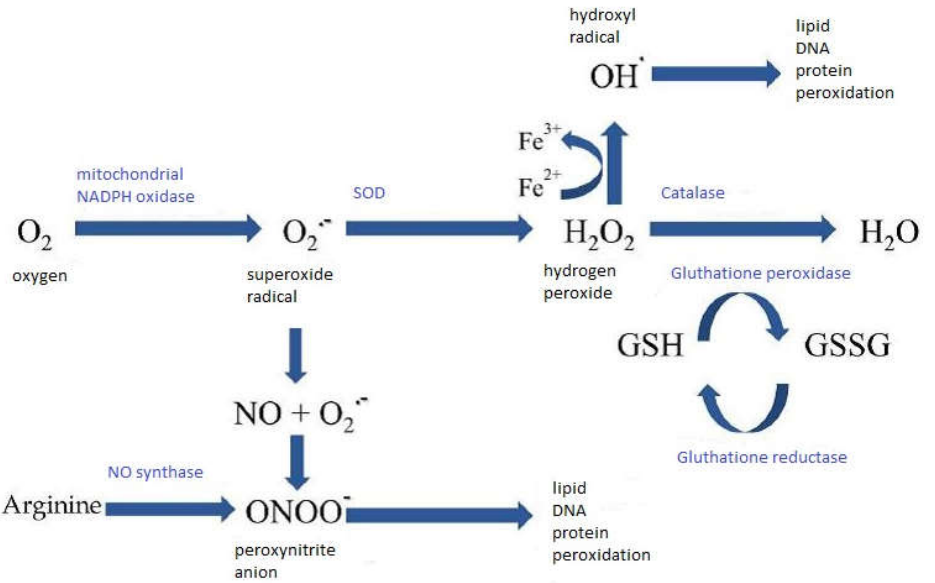
Figure 1. Production of Reactive Oxygen Species.